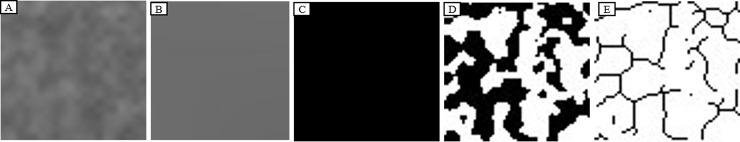
A. Original ROI cropped at molar region, B. Gaussian blurred image, C. Subtracted image, D. Thresholded image, E. Skeletonized image.